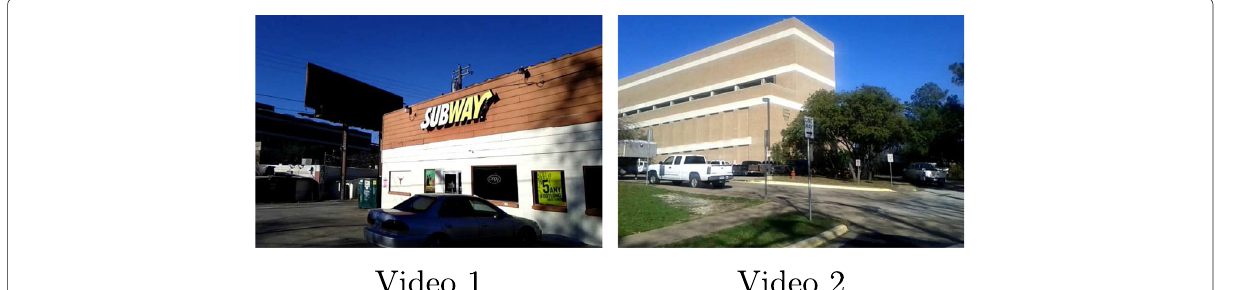
Fig. 6 Examples of frames extracted from the test